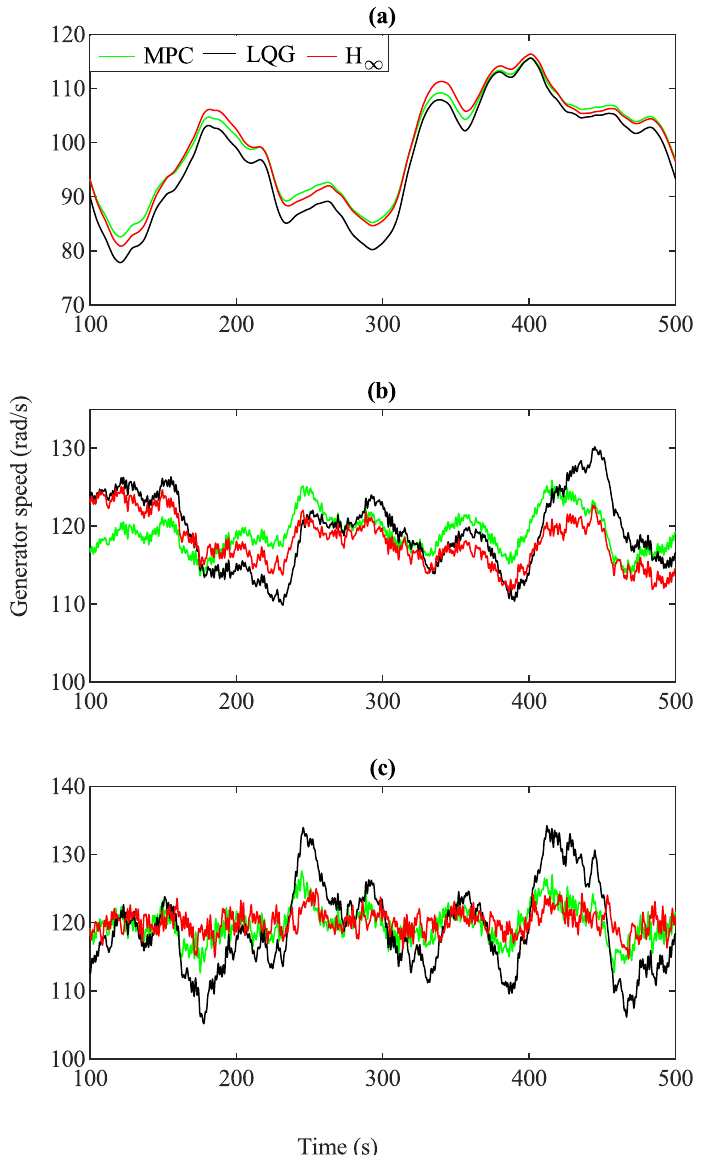
Figure 9. Time responses of control output (generator speed) in modes 1, 2, and 3: MPC, LQG, and H ∞ based on the Bladed linearization model; ( a ) mode 1, ( b ) mode 2, ( c ) mode